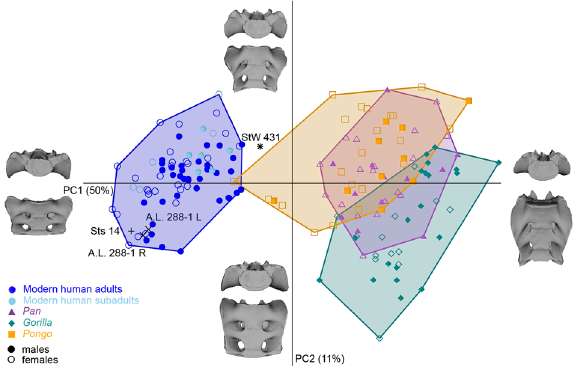
Fig. 2 PCA plot of the shape coordinates of the fi rst two sacral vertebrae and auricular surface after a Generalized Procrustes Analysis of the complete sample. Sts 14 and StW 431 (both attributed to Australopithecus africanus ) plot at opposite sides of the modern human distribution (blue circles = adults; sky-blue circles = subadults), while the two reconstructions of the A.L. 288-1 ( A. afarensis ) sacrum are close to Sts 14. The great apes (medium-orchid triangles = Pan ; dark-cyan diamonds = Gorilla ; orange squares = Pongo ) are separated from the hominins along PC1. PC1 is driven by the overall height-to-width ratio of the sacrum, and PC2 represents the orientation and relative antero-posterior width of the sacral alae. Closed symbols = males, open symbols = females.